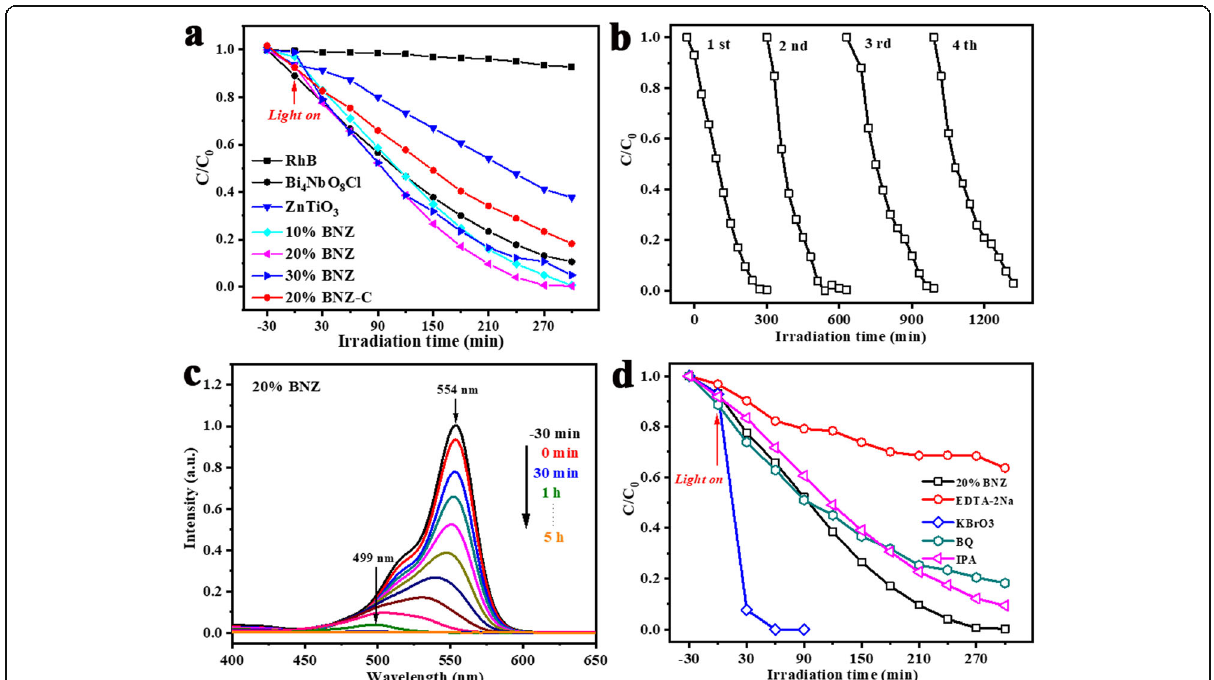
Fig. 3 a Photocatalytic degradation efficiencies of RhB with ZnTiO 3 , Bi 4 NbO 8 Cl, and BNZ heterojunctions under Xenon-arc lamp irradiation; b cycled runs of 20% BNZ; c changes in UV-vis absorption spectra of RhB by 20% BNZ under Xenon-arc lamp irradiation; d trapping experiments results of 20% BNZ with Xenon-arc lamp